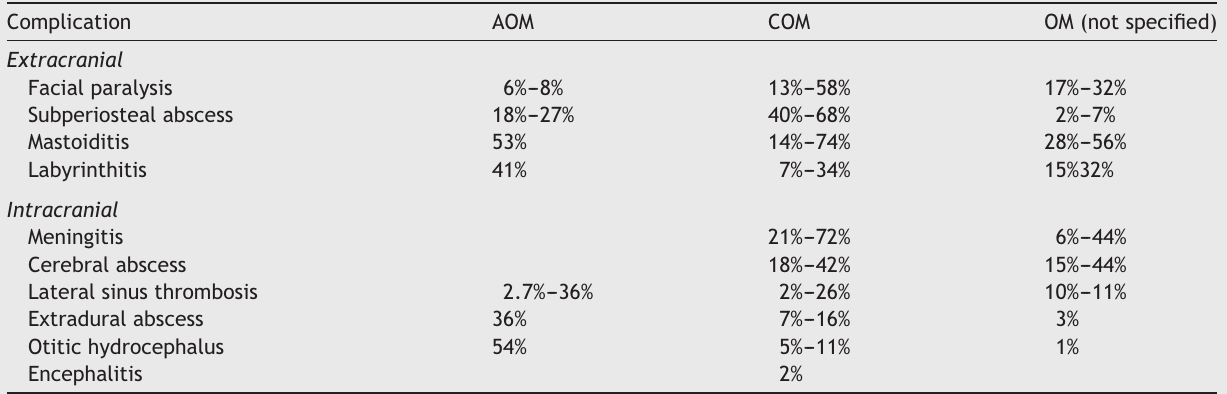
Table 1 Complication rates from otitis